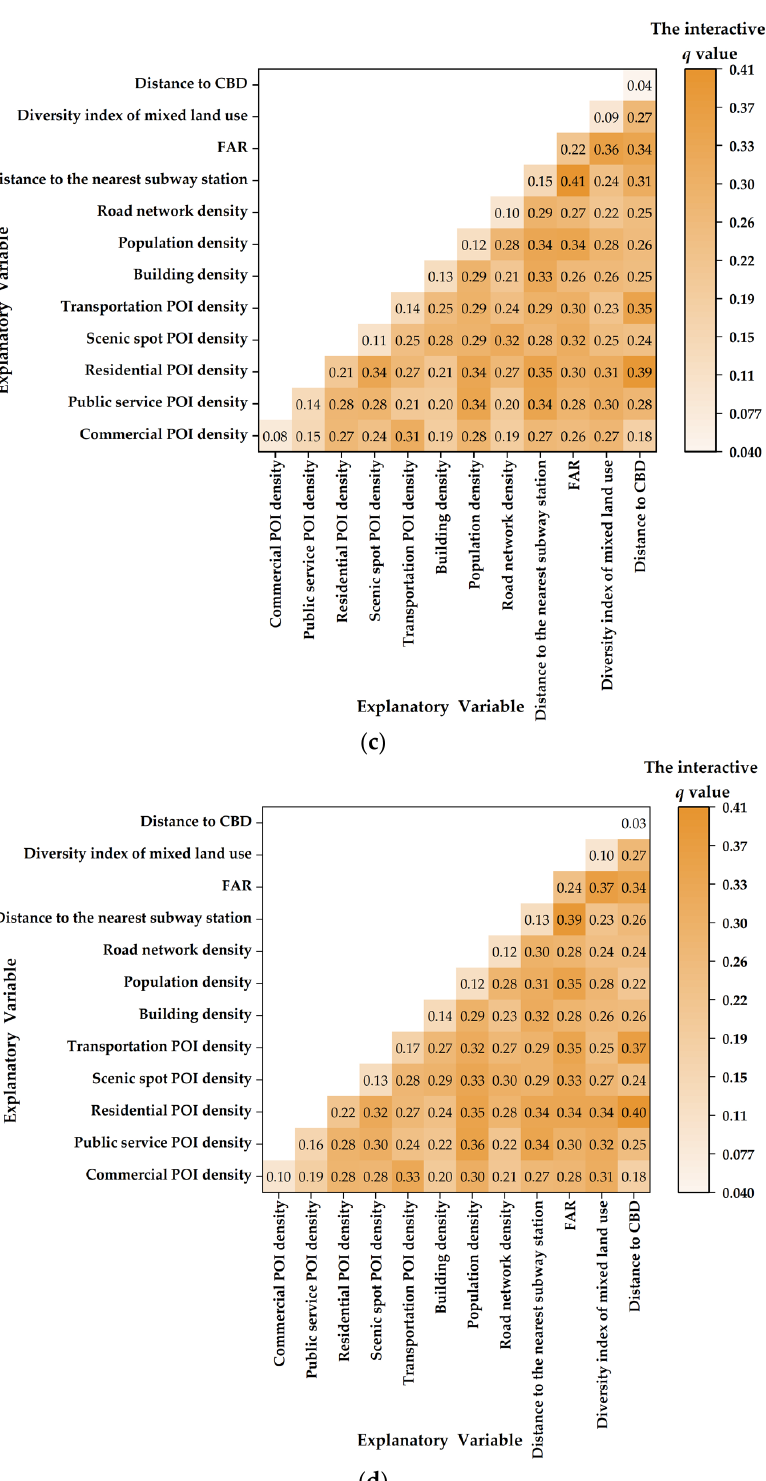
Figure 10. The results of the interactive detector for built-environment variables. ( a ) Pick-ups in the morning peak hours; ( b ) drop-offs in the morning peak hours; ( c ) pick-ups in the evening peak hours; and ( d ) drop-offs in the evening peak hours.